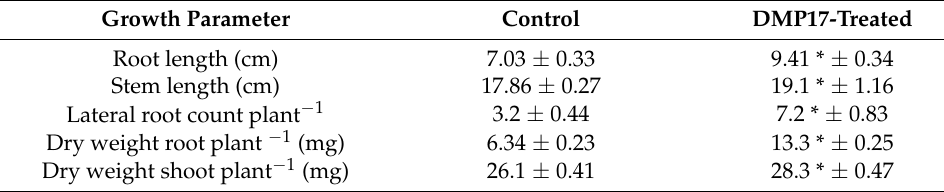
Table 2. Effects of DPM17 inoculation on the growth parameters of okra plants.